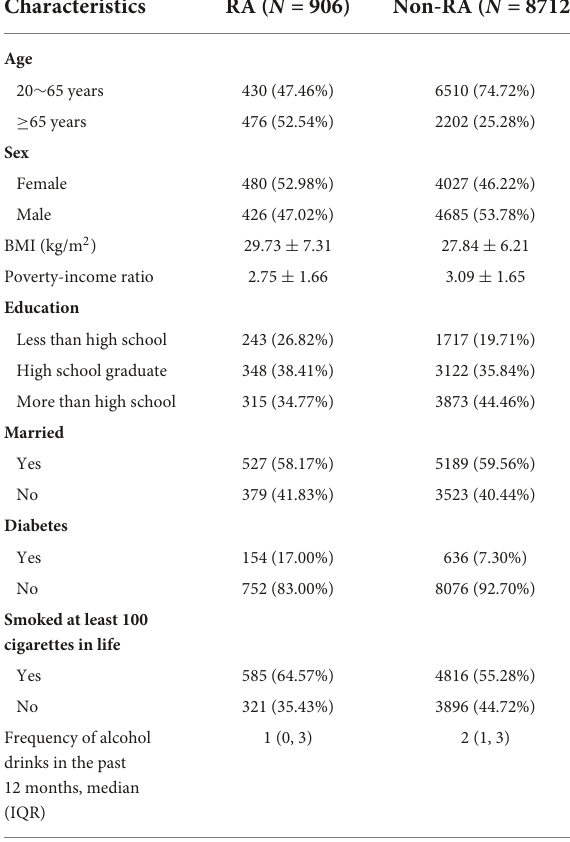
TABLE 1 Baseline characteristics of selected participants from National Health and Nutrition Examination Survey (NHANES)